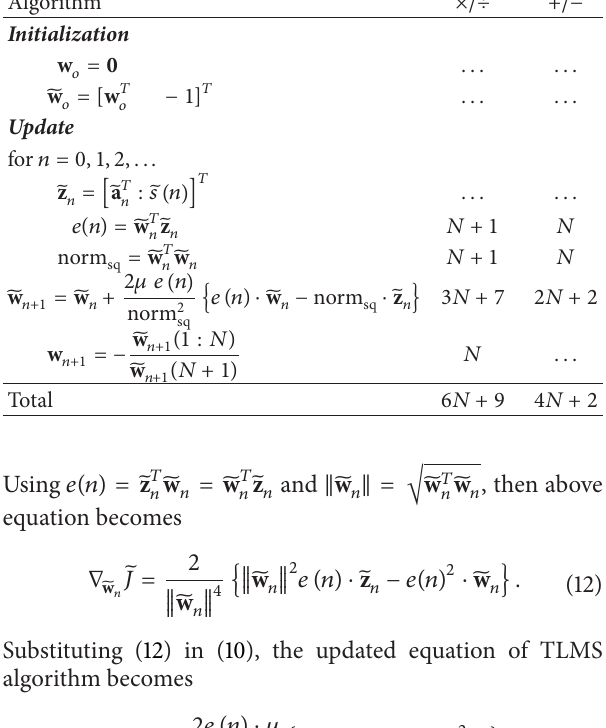
Table 1: LMS-total (TLMS) algorithm for adaptive filtering.